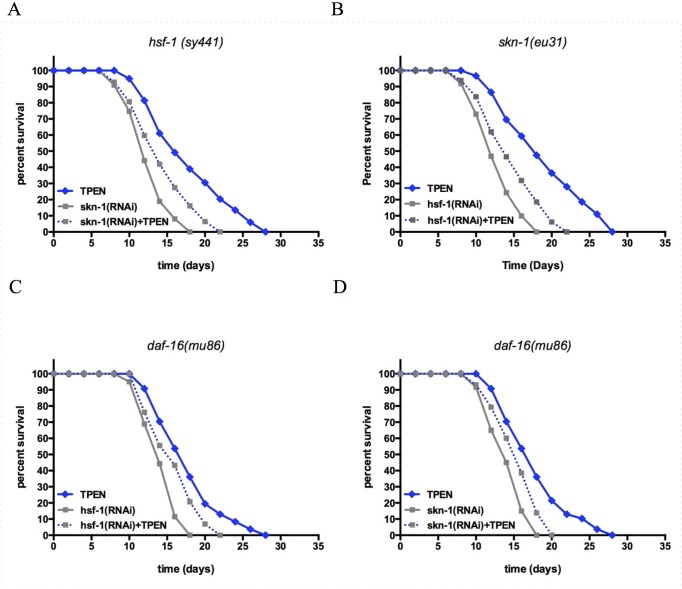
The effects of zinc availability on lifespan is dependent on HSF-1, SKN-1, and DAF-16 transcription factors in C. elegans.(A) Kaplan-Meier survival curve of worms with knockdown of hsf-1 exposed to TPEN as larvae. hsf-1 knockdown worms with or without knockdown of skn-1 were exposed to 200μM TPEN at the L3 stage. The effect of TPEN on lifespan in this mutant was reduced when skn-1 was also knockdown (p < 0.0001, log rank test). (B) Kaplan-Meier survival curve of worms with knockdown of hsf-1 exposed to TPEN as larvae. skn-1 knockdown worms with or without knockdown of hsf-1 were exposed to 200μM TPEN at the L3 stage. The effect of TPEN on lifespan in this mutant was reduced when hsf-1 was also knockdown (p < 0.0001, log rank test). (C) Kaplan-Meier survival curve of worms with knockdown of daf-16 exposed to TPEN as larvae. daf-16 knockdown worms with or without knockdown of hsf-1 were exposed to 200μM TPEN at the L3 stage. The effect of TPEN on lifespan in this mutant was reduced when hsf-1 was also knockdown (p < 0.0001, log rank test). (D) Kaplan-Meier survival curve of worms with knockdown of daf-16 exposed to TPEN as larvae. daf-16 knockdown worms with or without knockdown of skn-1 were exposed to 200μM TPEN at the L3 stage. The effect of TPEN on lifespan in this mutant was reduced when skn-1 was also knockdown (p < 0.0001, log rank test).